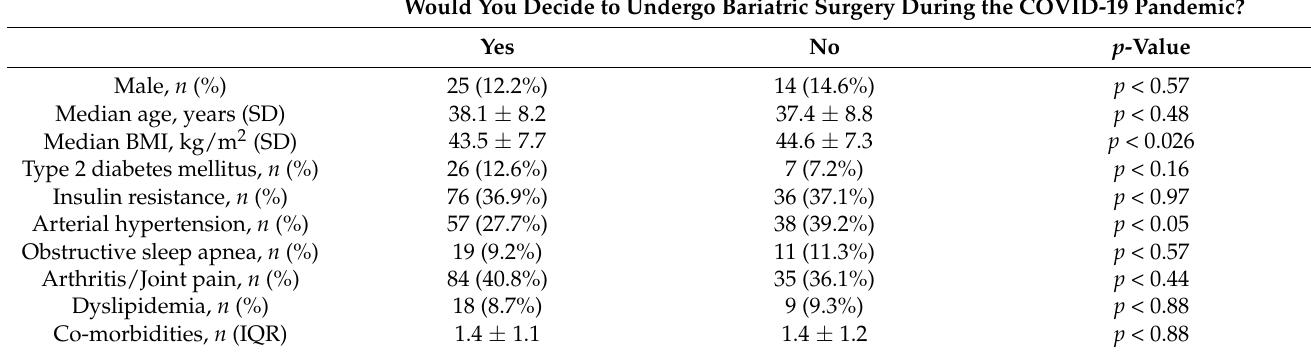
Table 3. Decision about bariatric surgery during the COVID-19 pandemic—pre-operative patients. Would You Decide to Undergo Bariatric Surgery During the COVID-19 Pandemic?